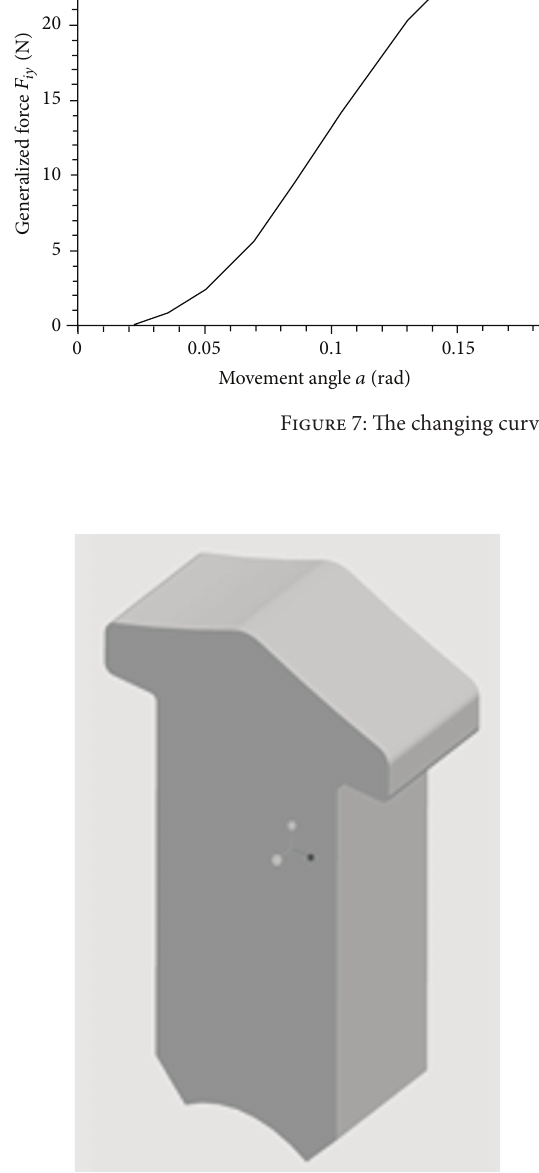
Figure 8: The model of the cropping